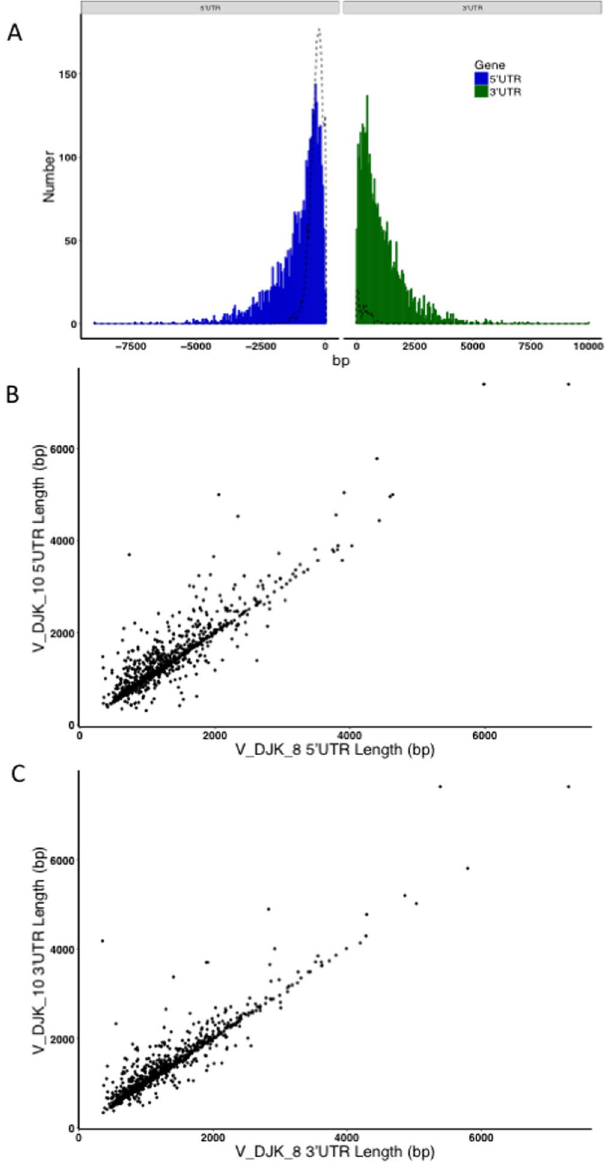
Figure 3. Distribution of the length of untranslated regions for full-length protein-coding transcripts. ( A ) The histogram shows the number of protein-coding transcripts (y-axis) with a given 5 ′ - and 3 ′ -UTR length (x-axis, in blue and green respectively). The dashed line represents the currently annotated UTR length for all P. vivax protein-coding genes. ( B ) Pair-wise comparison of 5 ′ UTR lengths between samples V_DJK_10 and V_DJK_8. ( C ) Pair-wise comparison of 3 ′ UTR lengths between samples V_DJK_10 and V_DJK_8. Additional comparisons in Supplemental Figure